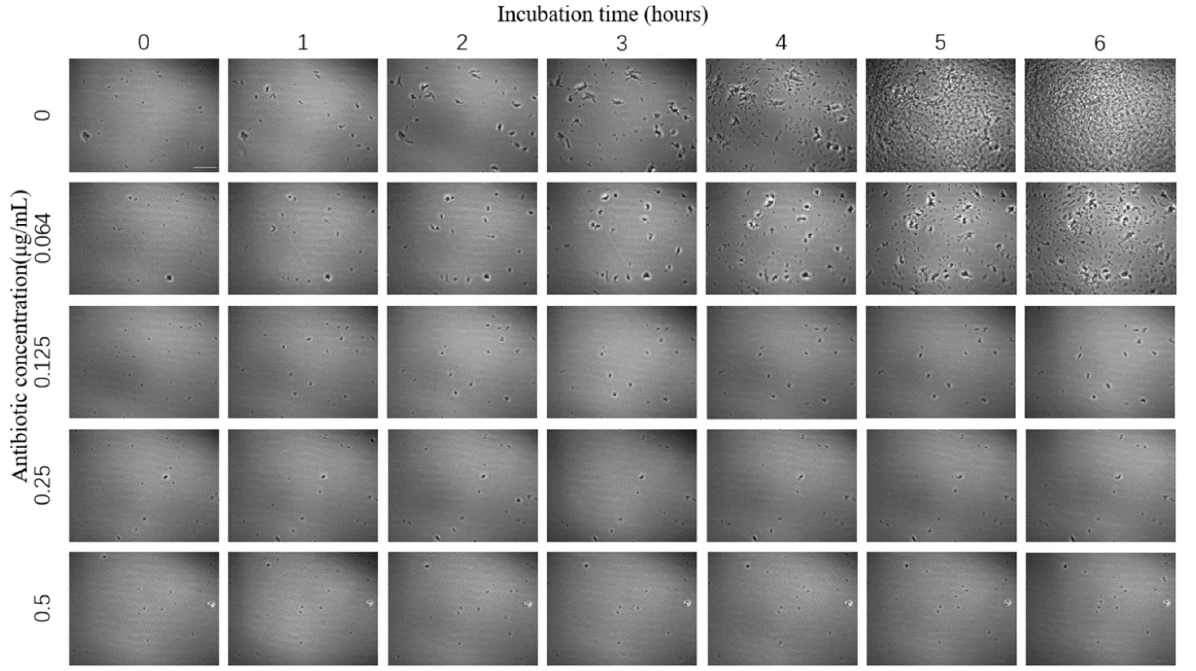
Figure 4. Images of E. coli at different times under the effect of different concentrations of tigecycline. Scale bar, 30 μm.